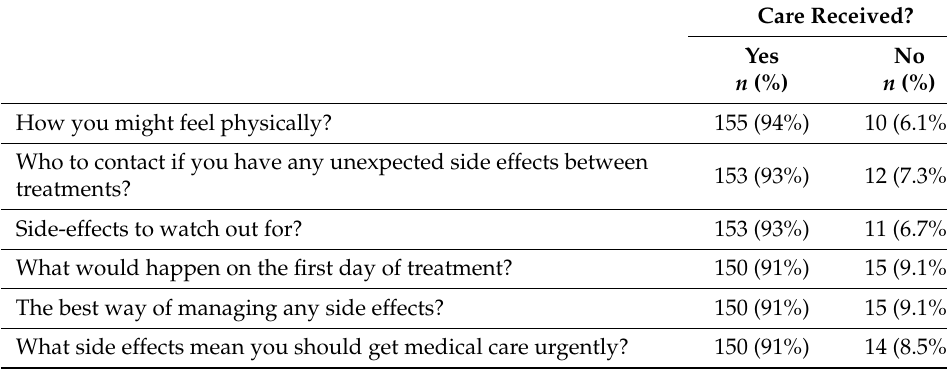
Table 2. The proportion of participants reporting receiving care for each item ( n =